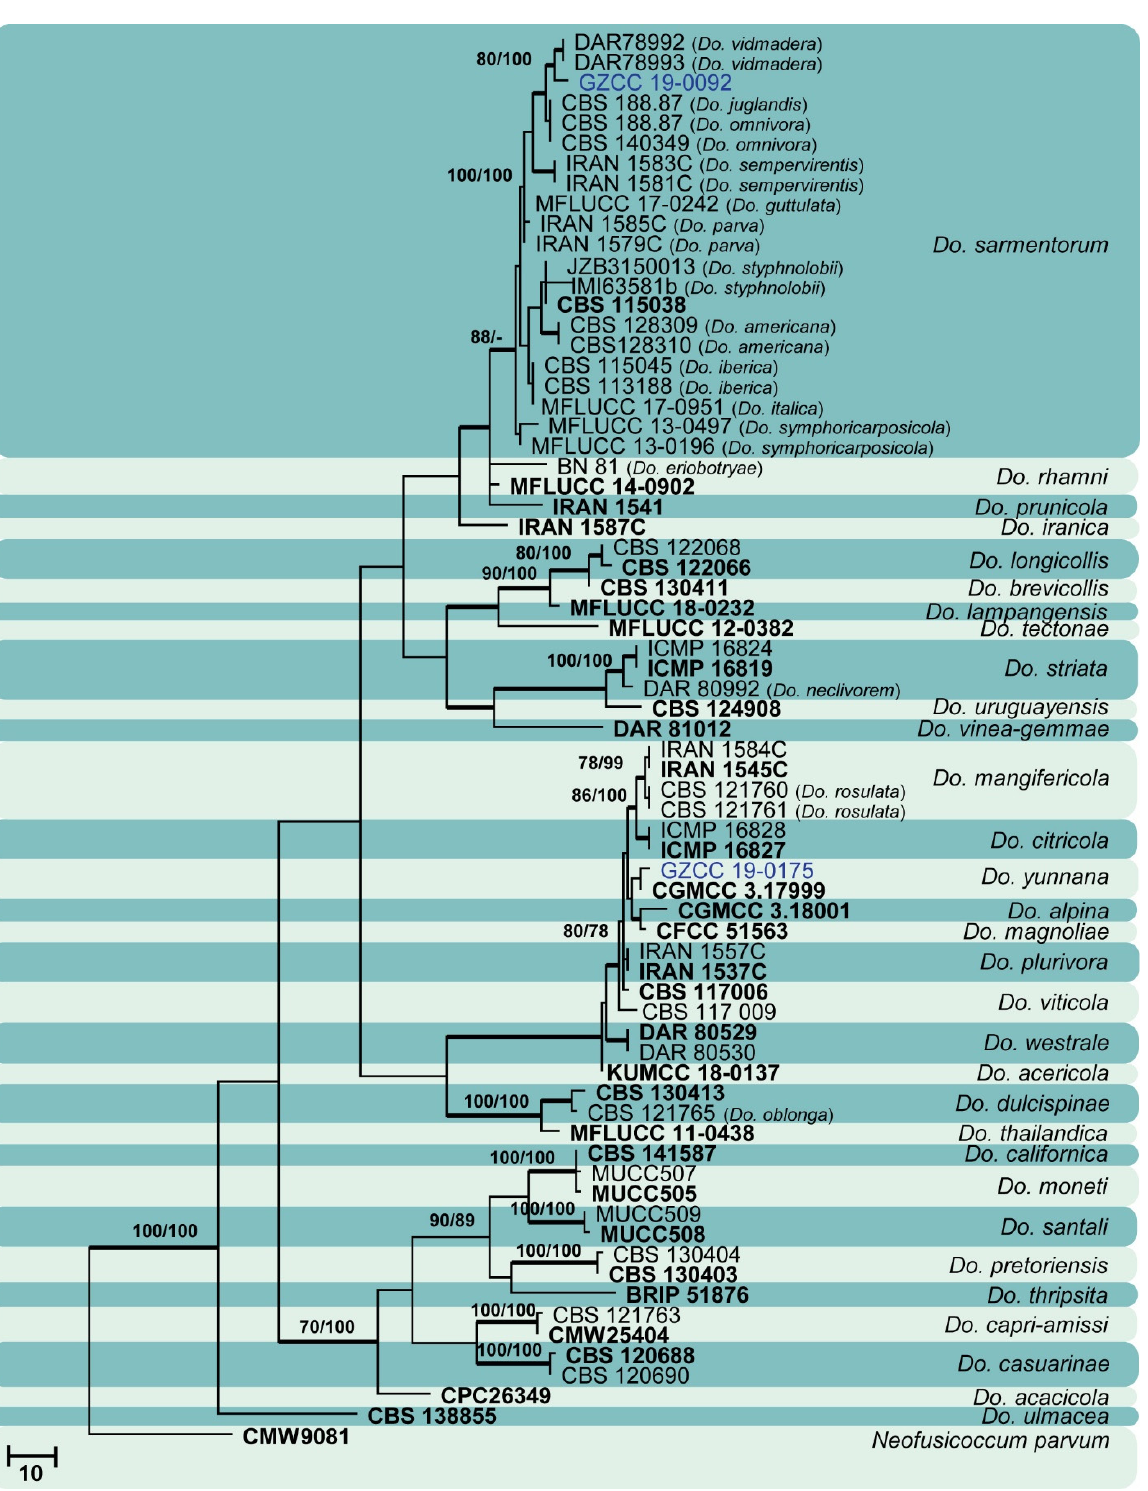
Figure 12. Maximum likelihood tree based on analysis of combined ITS and tef sequences of Dothiorella . Bootstrap support values of ML, MP > 75% are shown near the nodes, and branches in bold indicate BI probabilities >0.95. Isolates obtained in this study are in blue for known species. Ex-type strains are in bold. The tree is rooted to Neofusicoccum parvum (CMW9081).